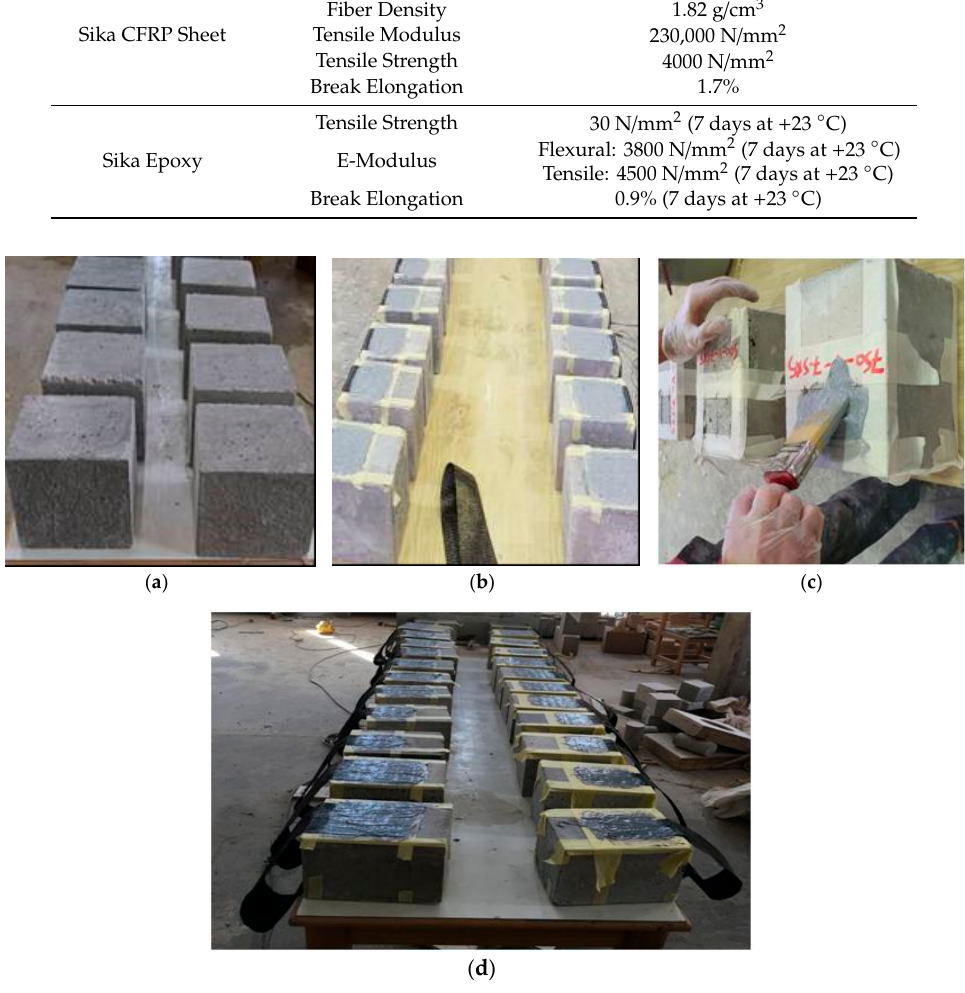
Figure 3. Bonding of the CFRP sheets ( a ) without surface preparation; ( b ) smooth surface preparation; ( c ) preparation of grooves; ( d ) specimens with di ff erent CFRP composite sheet lengths and widths.